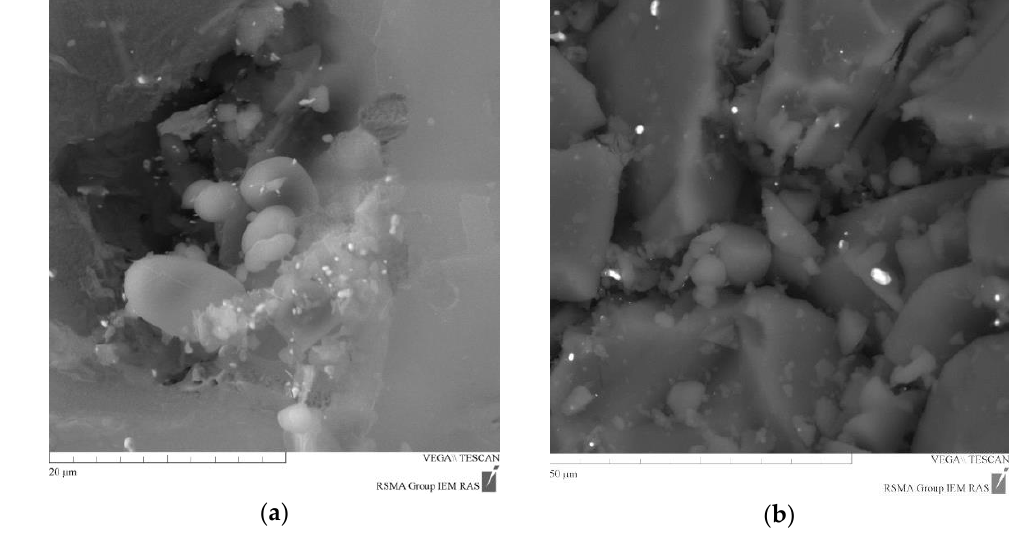
Figure 3. : Products of experiments with reduced carbonic fluid at P = 200 MPa and T = 950 °C ( a ) SEM micro-image of quenching glass balls with Pt, run ab84 on the bottom of the capsule; ( b ) SEM micro-image of Pt microparticles on the surface of quartz glass shreds of the fluid trap from experiment qz98.